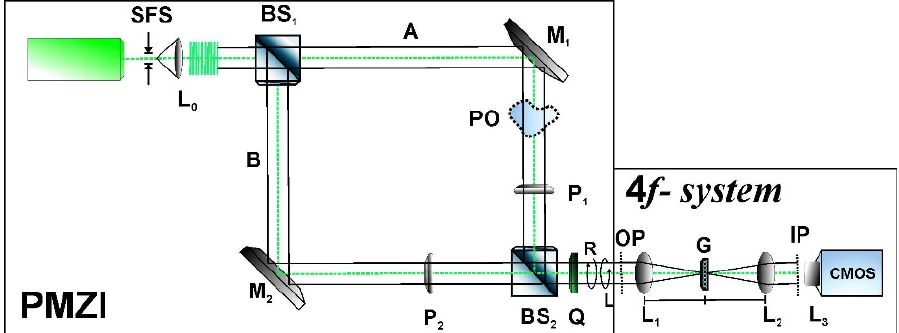
Figure 3. Experimental setup. Laser operating at 532 nm. SFS: spatial filter system. L 0 : collimated lens. Pi: linear polarizers. M i : mirrors. BS: beam splitter. Q: quarter-wave plate. G: 2D grating. L 1 , L 2 : lenses of 4 f system. L 3 : zoom lens. IP: image plane. PO: phase object.